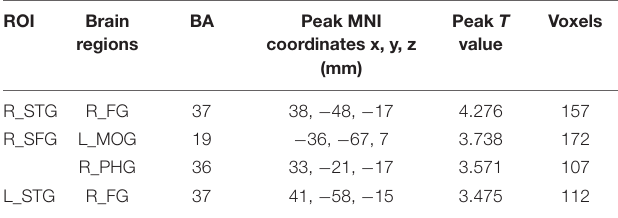
TABLE 3 | Brain regions with significant group differences in CBF